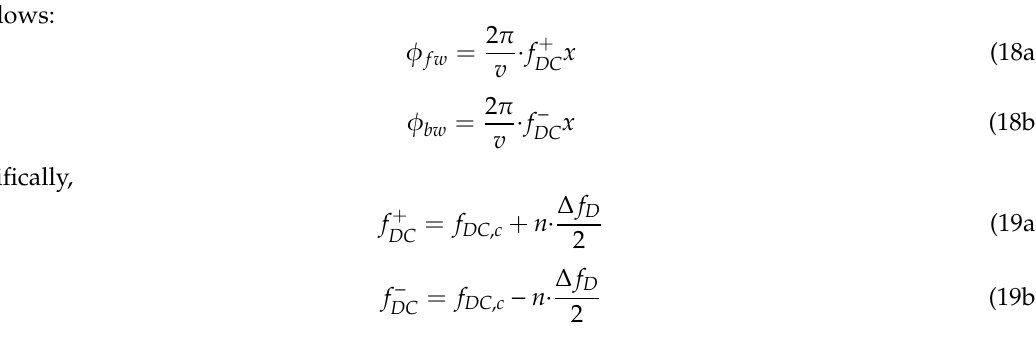
resolution inversely proportional to the band of the signal [89], the spatial resolution of the two sub- band interferograms is reduced by the same fraction.